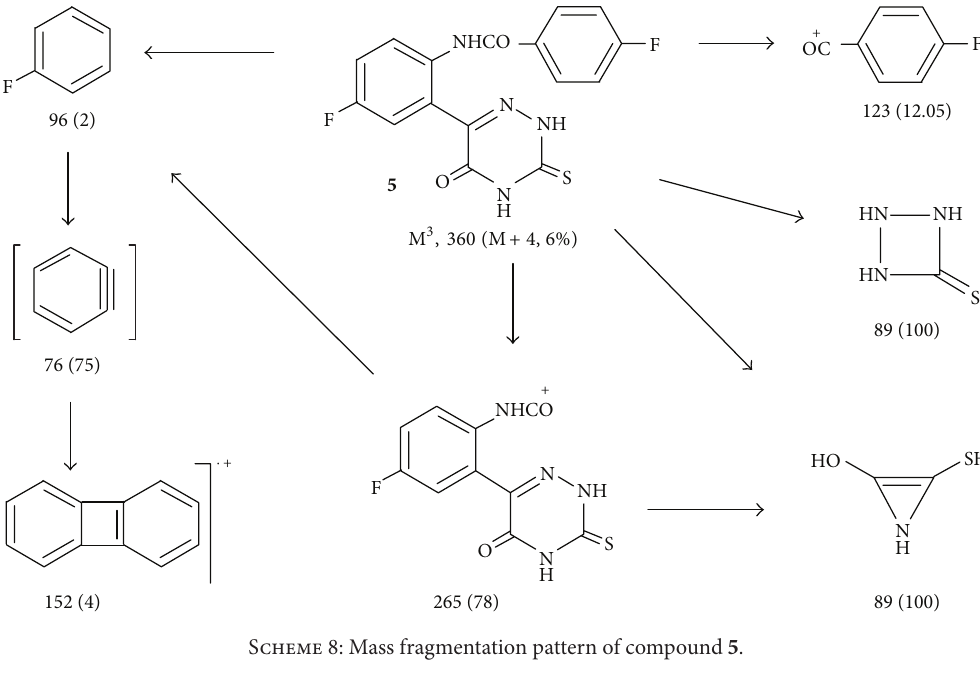
Scheme 8: Mass fragmentation pattern of compound 5 .